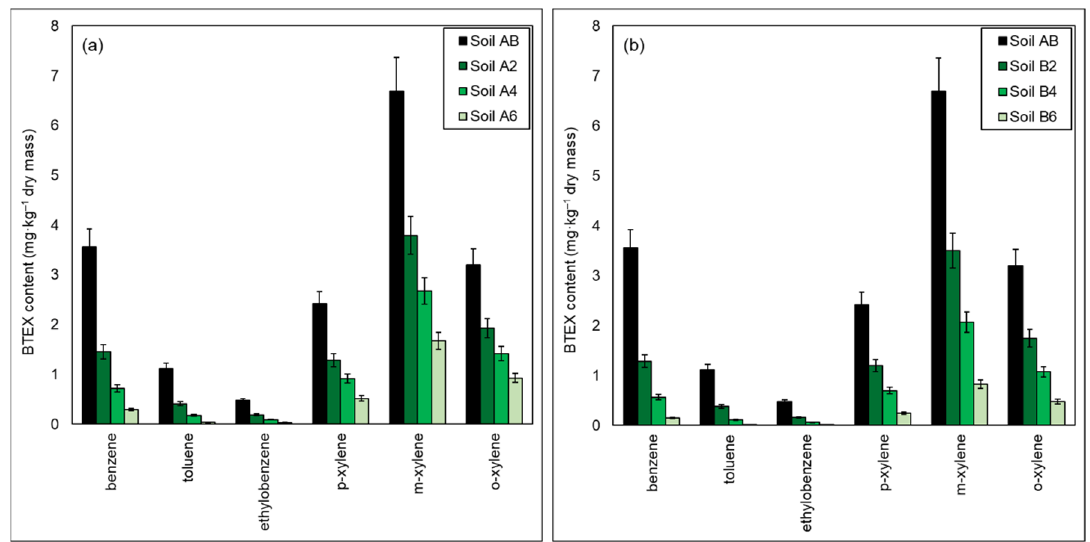
Figure 4. Residual content of BTEX in soil contaminated petroleum hydrocarbons inoculated ( a ) biopreparation A1, ( b ) biopreparation A1 with the addition of γ -PGA after 2 (Soil A2/Soil B2), 4 (Soil A4/Soil B4) and 6 (Soil A6/Soil B6) months of the biodegradation process carried out in ex-situ conditions. Control was non-inoculated Soil AB. (repetition number n = 7–10, p < 0.05).